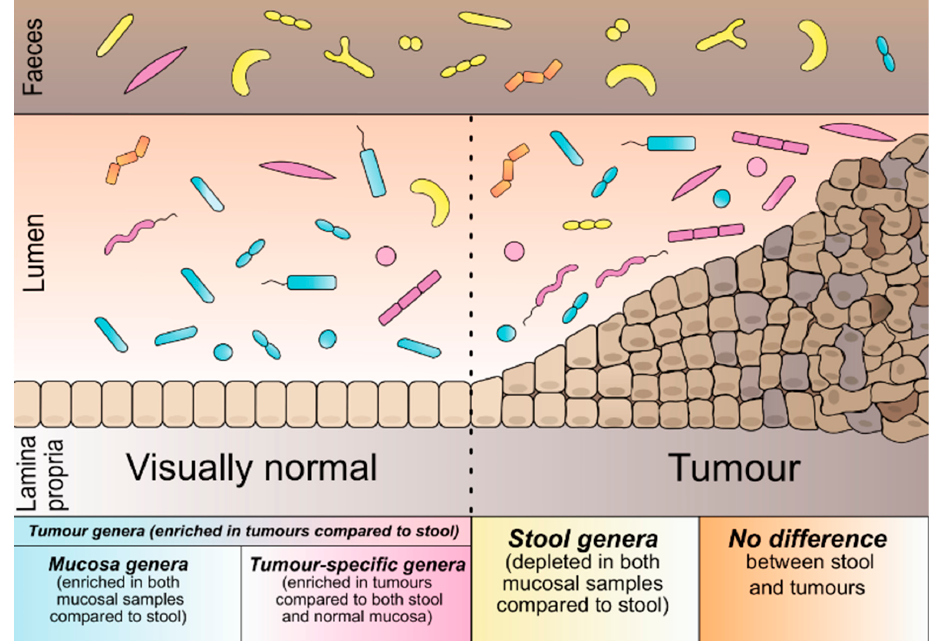
Figure 1. Schematic representation of bacterial categories according to their preferred environment.